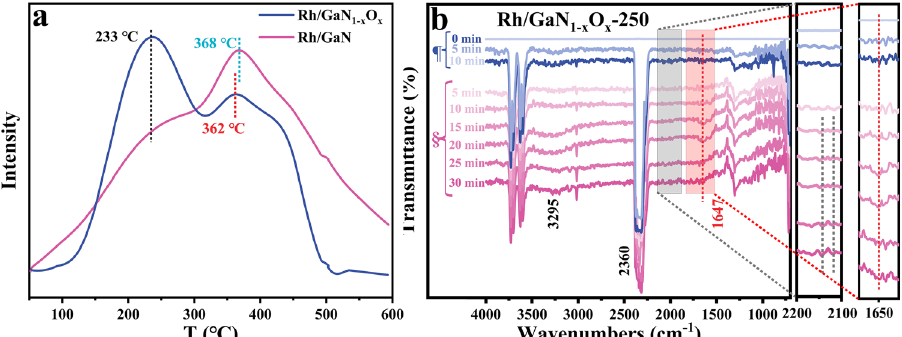
Fig. 4 Spectroscopic analysis of catalytic mechanism. The desorption behavior of a CO over Rh/GaN and Rh/GaN 1 – x O x -250 by TPD. b In situ DRIFT spectra of Rh/GaN 1 – x O x -250, ¶: from room temperature to 260 °C; §: keeping 260 °C.